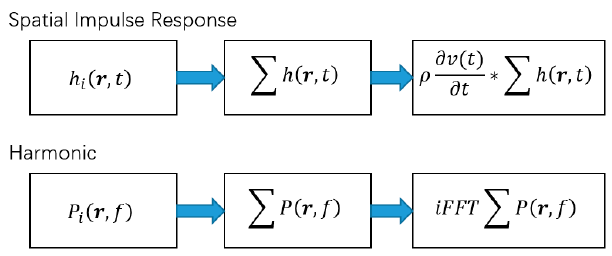
Figure 11. The main calculation steps for the transient radiated field.